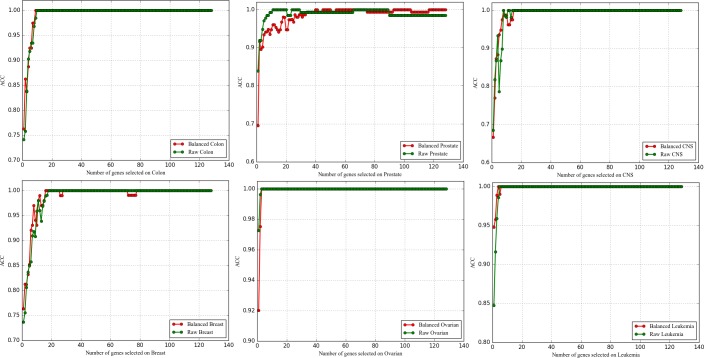
The comparison of ACC obtained on six balanced and raw datasets.